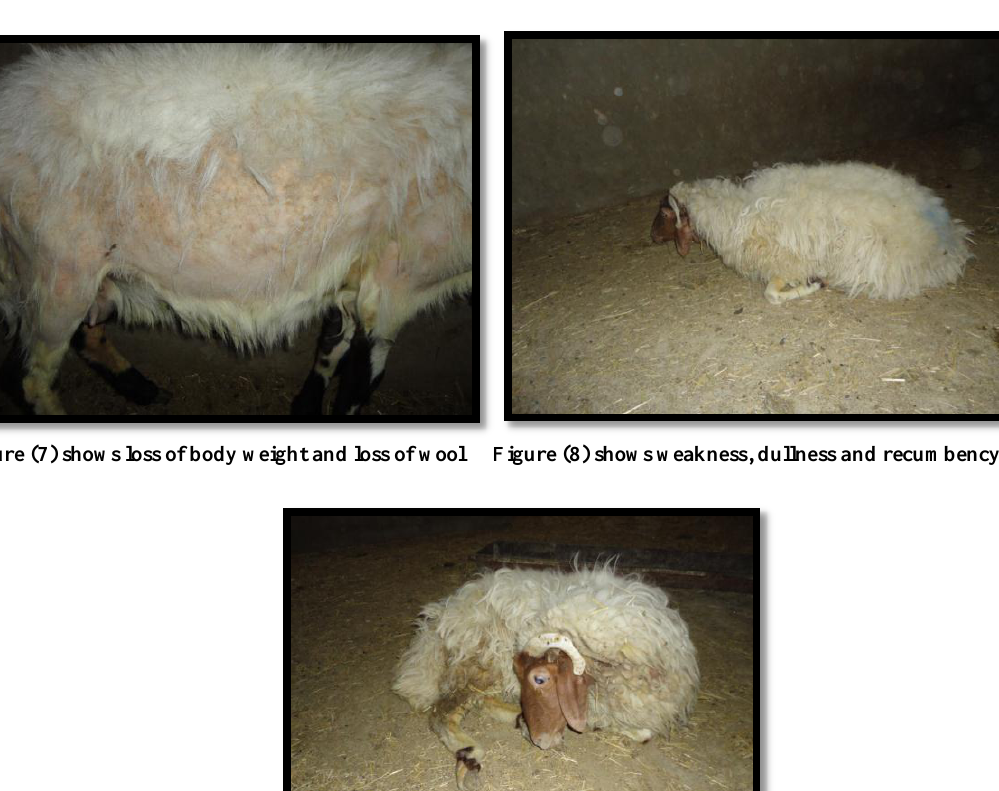
Figure (5) shows paleness of heart muscle Figure (6) shows loss of body weight and loss of wool